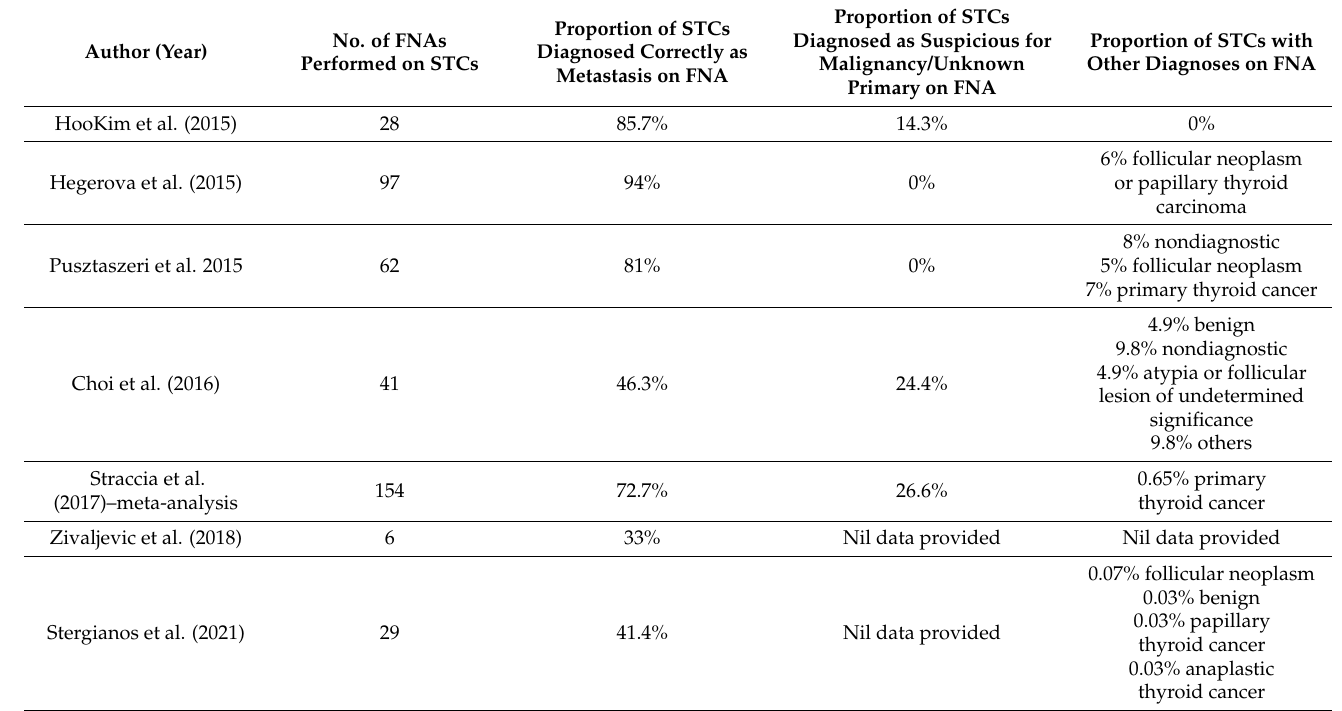
Table 2. Cytological diagnoses of secondary thyroid cancers by fine needle